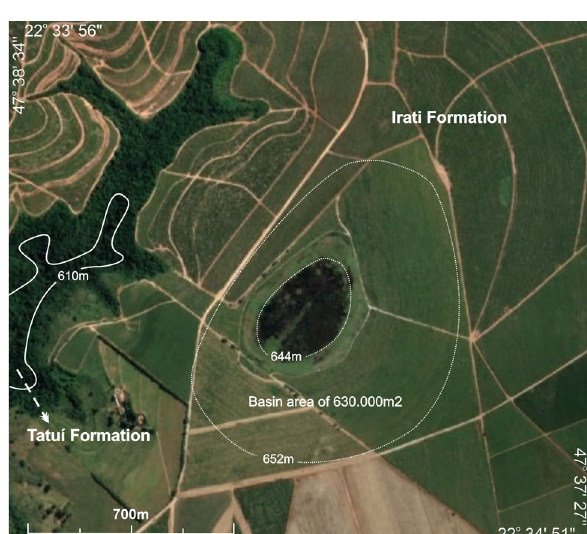
Fig. 3 Topographic eleva- tions of the wetland area and upper limit of the basin, with geological contact of the Irati Formation (upper) and Tatuí Formation